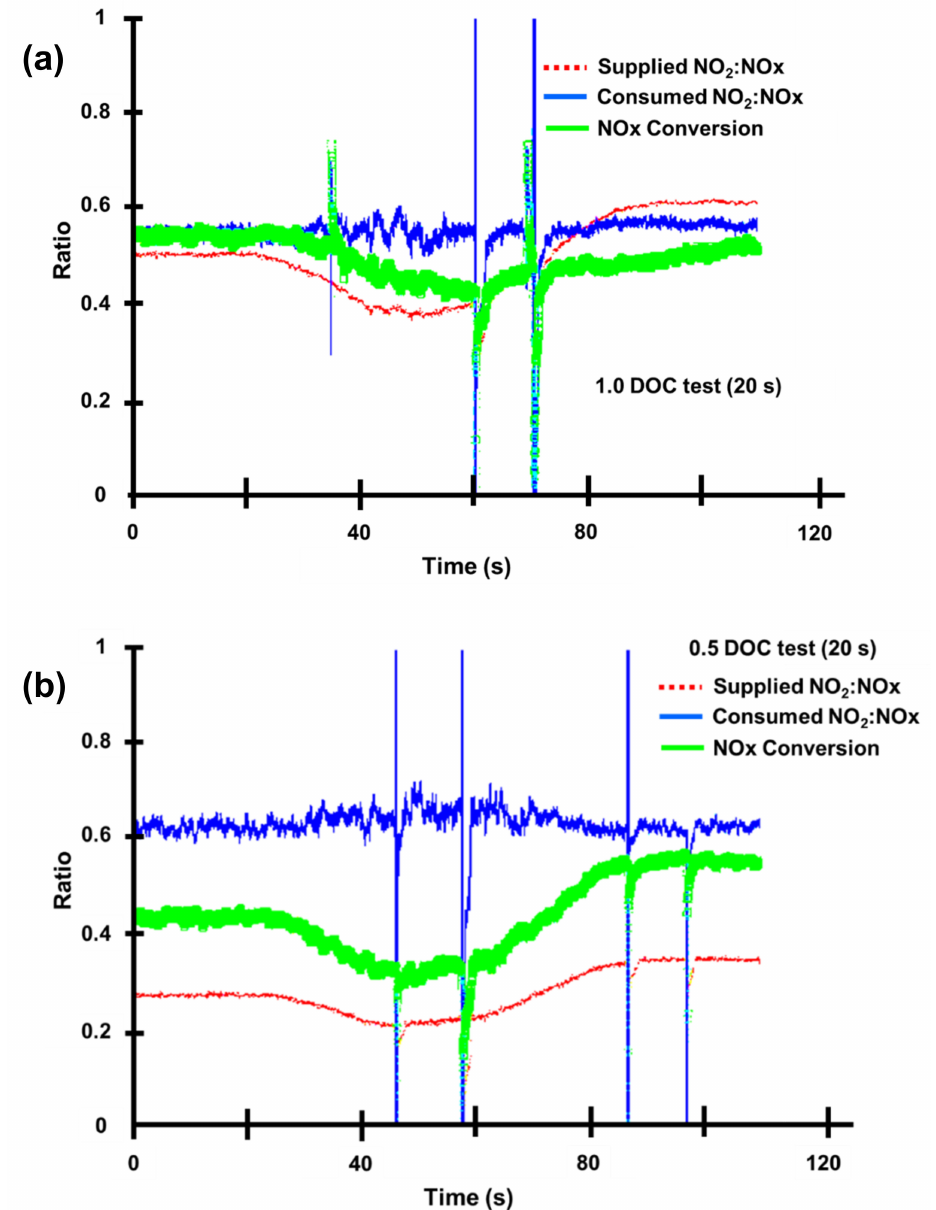
Figure 12. Graphs demonstrating that the consumed NO 2 :NOx ratio was unaffected by the supplied NO 2 :NOx ratio during the transient. ( a ) 1,0 DOC test 0n the 20 s and ( b ) 0,5 DOC test on 20 s. The graph spikes are insignificant instrumentation errors from the CLD analyzer, adapted from Benjamin et al.